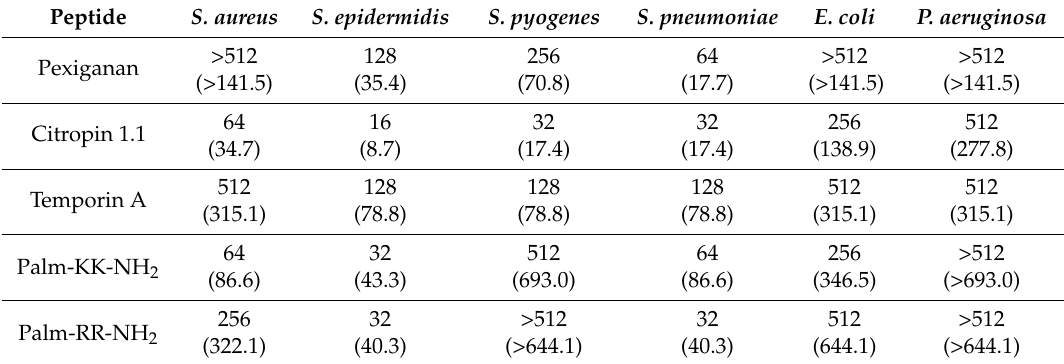
Table 2. Minimum biofilm eradication concentration (reduction of resazurin ≤ 10% ± 0.5%) at 37 ◦ C in µ g/mL ( µ M).